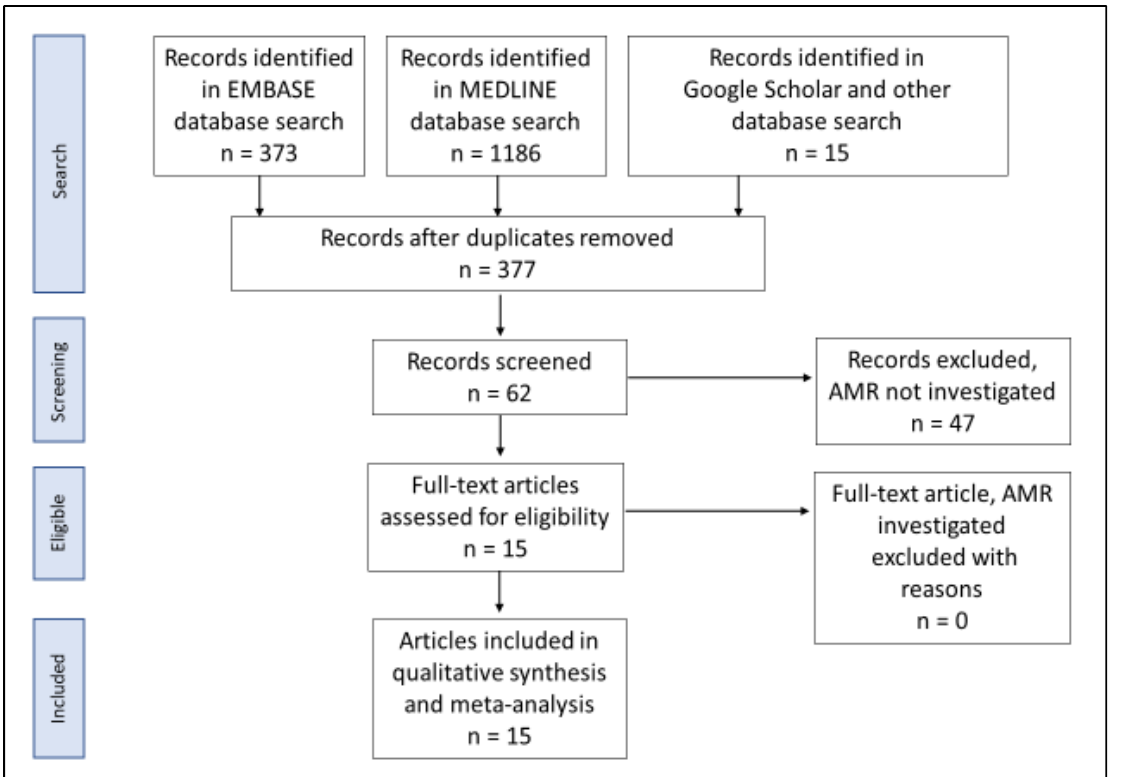
Figure 1. PRISMA [19] flow chart of article search, article inclusion and exclusion, and the number of studies included in this study-systematic review and meta-analysis.